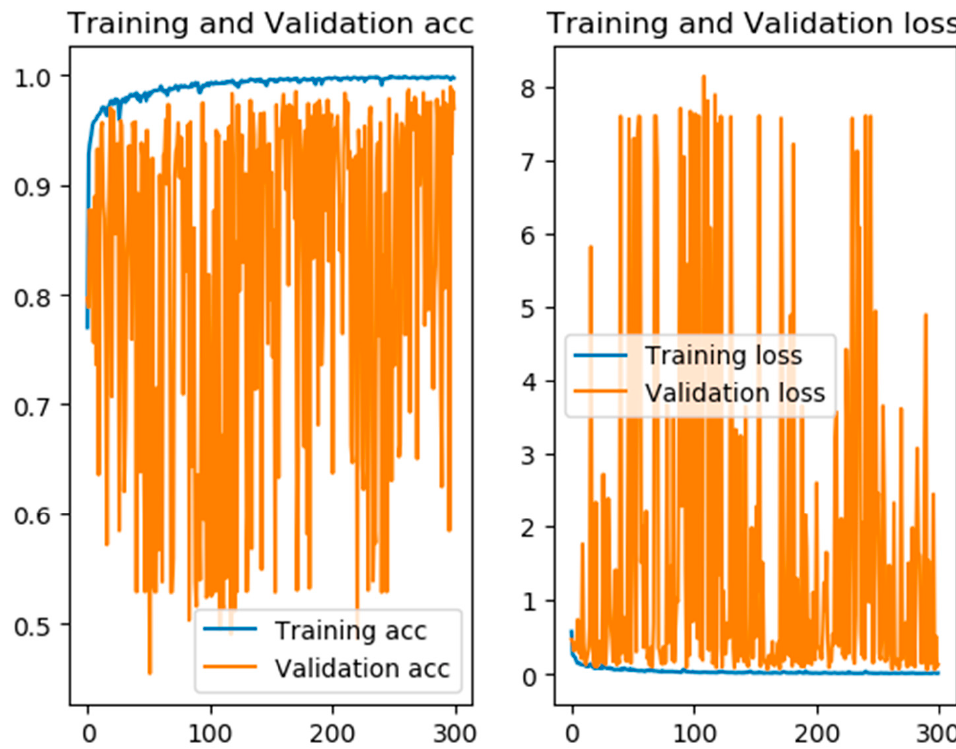
Figure 5. Model training process and results. The left figure denotes the accuracy changes with epochs, whereas the right one denotes loss changes with the epochs. The bule and orange lines represent the accuracy and loss for the training and validation datasets, respectively.